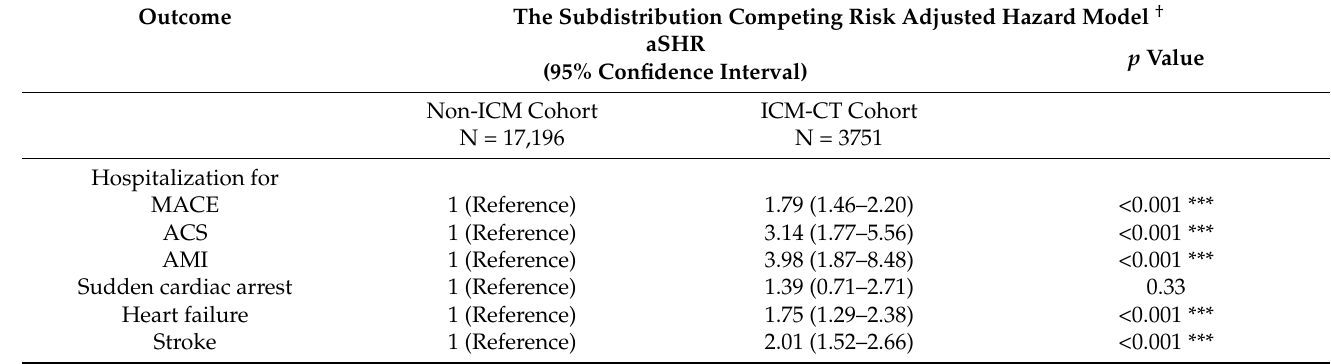
Table 3. Adjusted subhazard ratio (aSHR) of MACEs in the ICM-CT cohort using competing risk regression